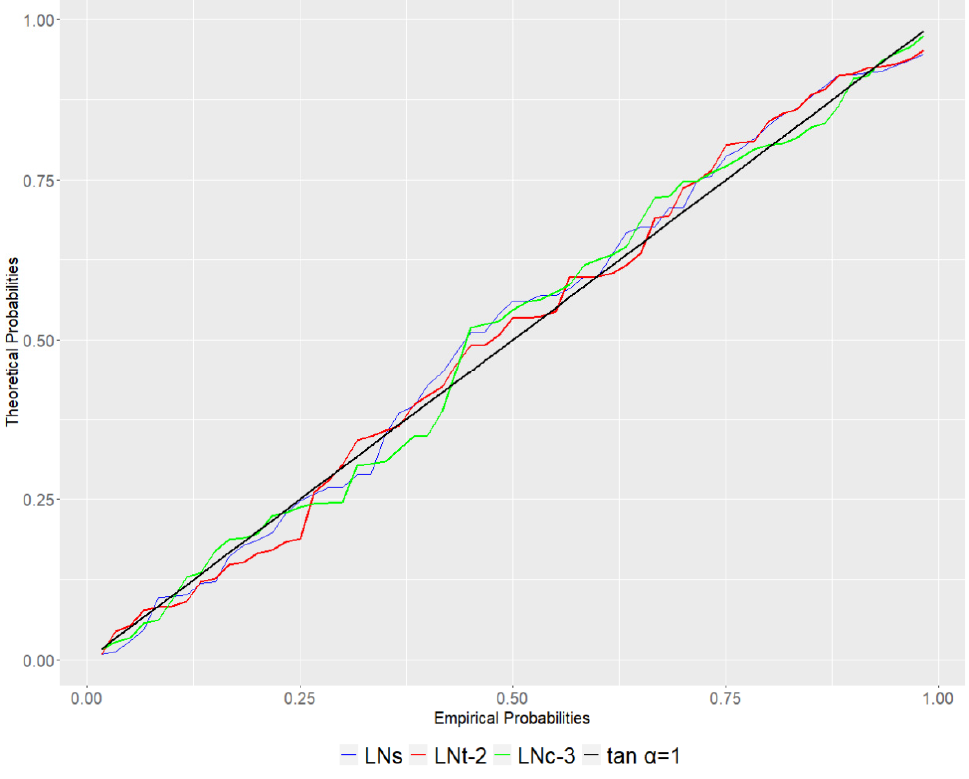
Figure 5. The PP-plot of the optimal models for each case.